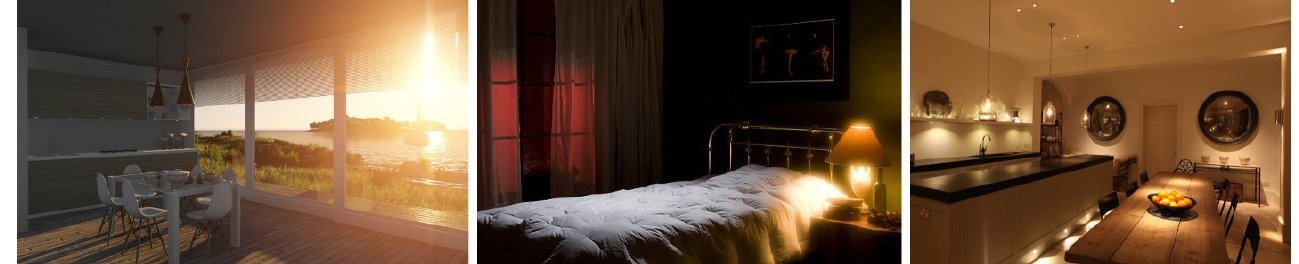
Figure 6. Example of non-fire images in our dataset.